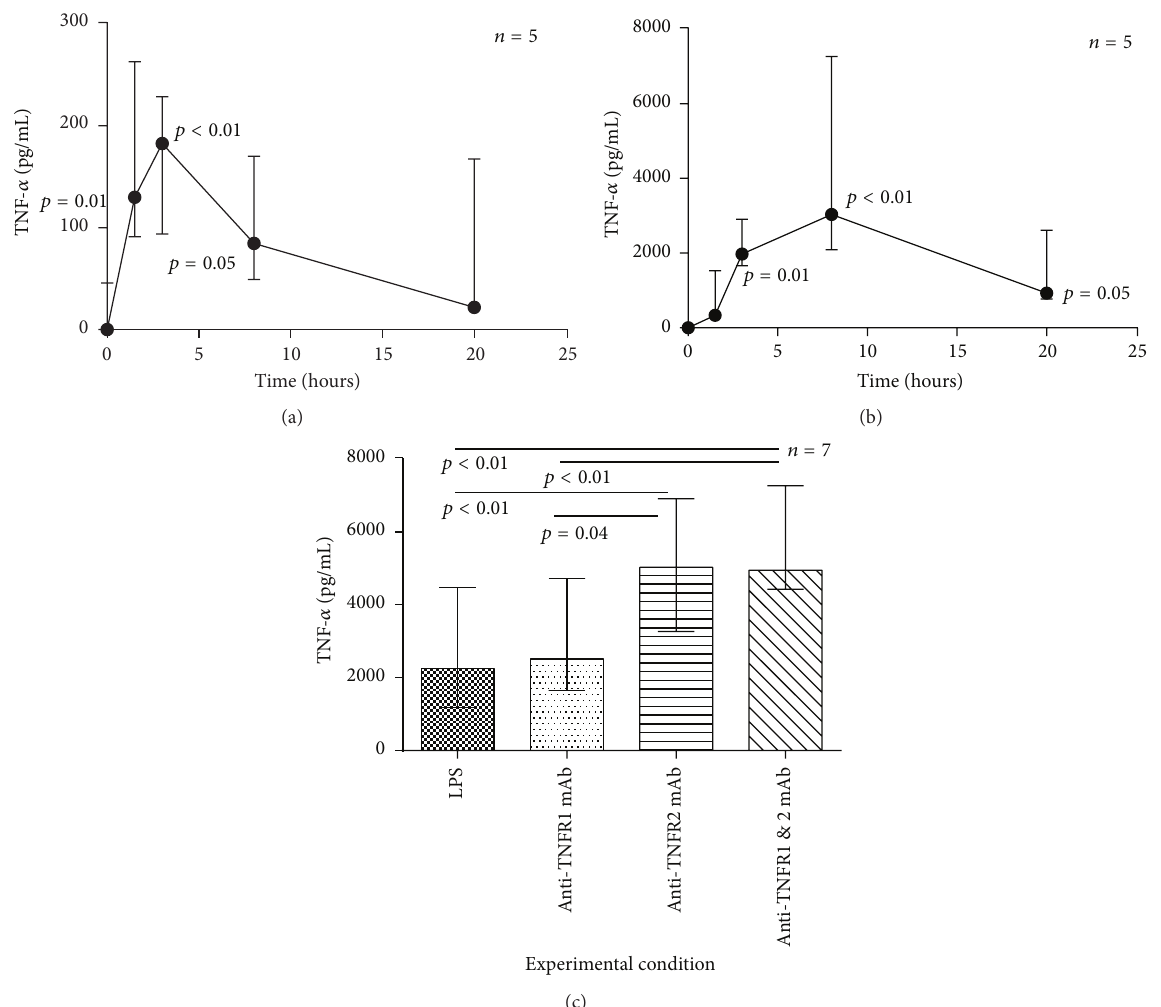
Figure 6: Autocrine binding of sTNF- 𝛼 secreted by monocytes. Time course profiles for monocytes cultured alone (a) or with 100ng/mL of LPS (b) are shown. Each datum point is the median value (range). (a) Friedman’s test: 𝑝 < 0.01 . Significant post hoc pairwise comparisons of each time point to time zero are shown in the graphs. (b) Friedman’s test: 𝑝 < 0.001 . Significant post hoc pairwise comparisons of each time point to time zero are shown in the graphs. (c) Monocytes were cultured with 100ng/mL of LPS for 20 hours ± 10 𝜇 g/mL of TNFR1 mAb or TNFR2 mAb or both mAbs. Each column shows median and IQR values. Friedman’s test: 𝑝 < 0.001 . Post hoc pairwise comparisons 𝑝 values are shown in the figures. The experiments represent data from 5 subjects (a and b) or 7 subjects (c). Time points in (a) and (b) were conducted in culture wells singly and experimental conditions in (c) in duplicate. Each sample was run in duplicate on the subsequent